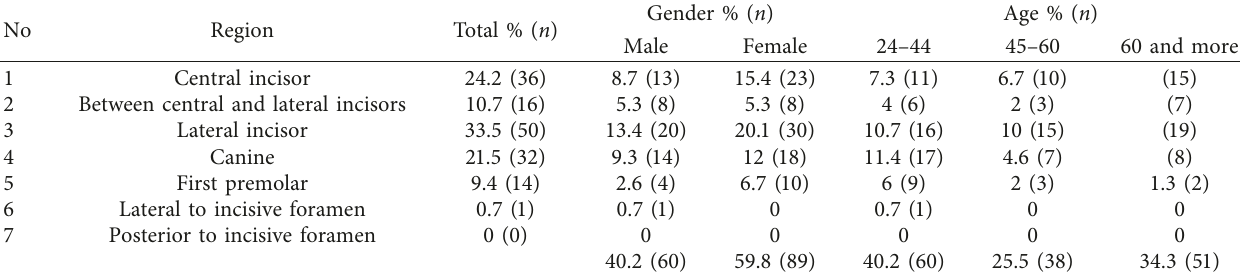
Table 1: CS localization according to Oliveira-Santos et al.